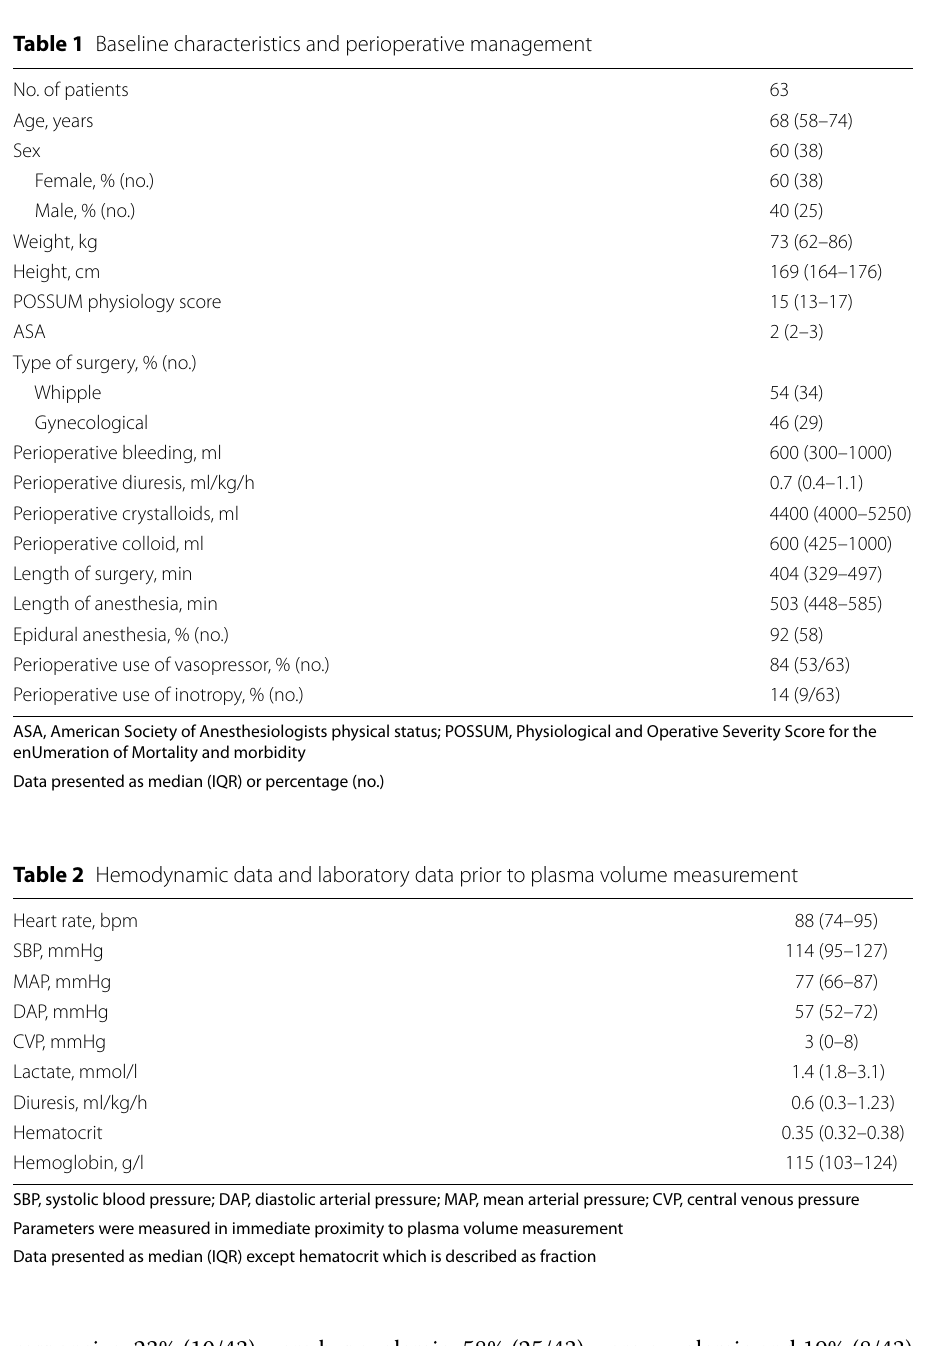
Table 1 Baseline characteristics and perioperative management